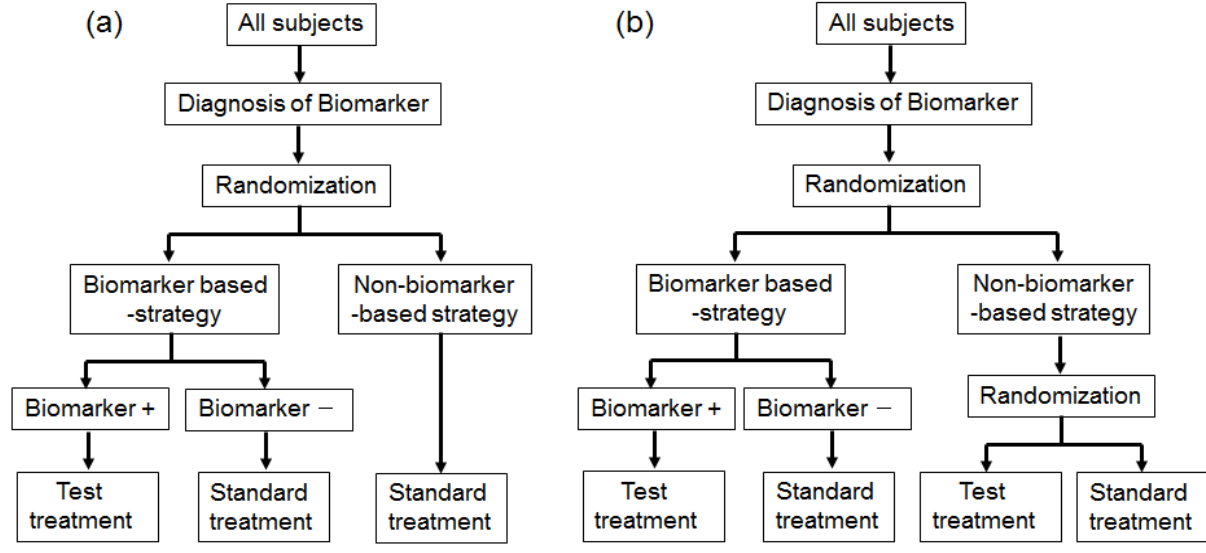
Figure 3. Biomarker-strategy design. ( a ) With standard control and ( b ) with randomized control. ‘+’ and ‘–’ correspond to the respective positive and negative biomarker